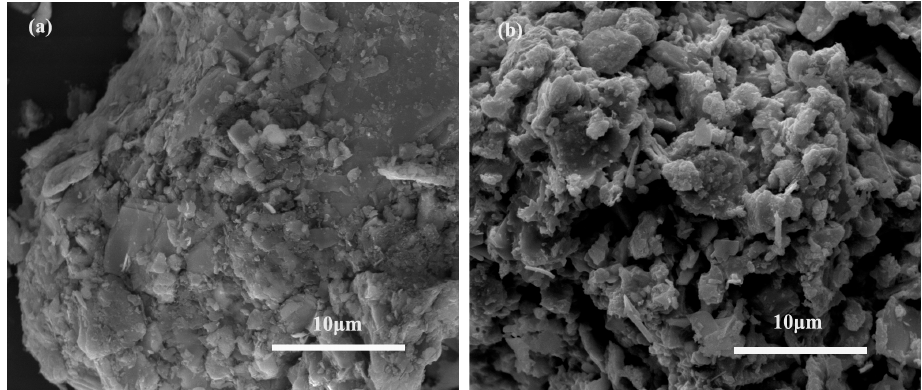
Figure 12. SEM images of bauxite: ( a ) raw ore; ( b ) ore roasted at 600 °C.